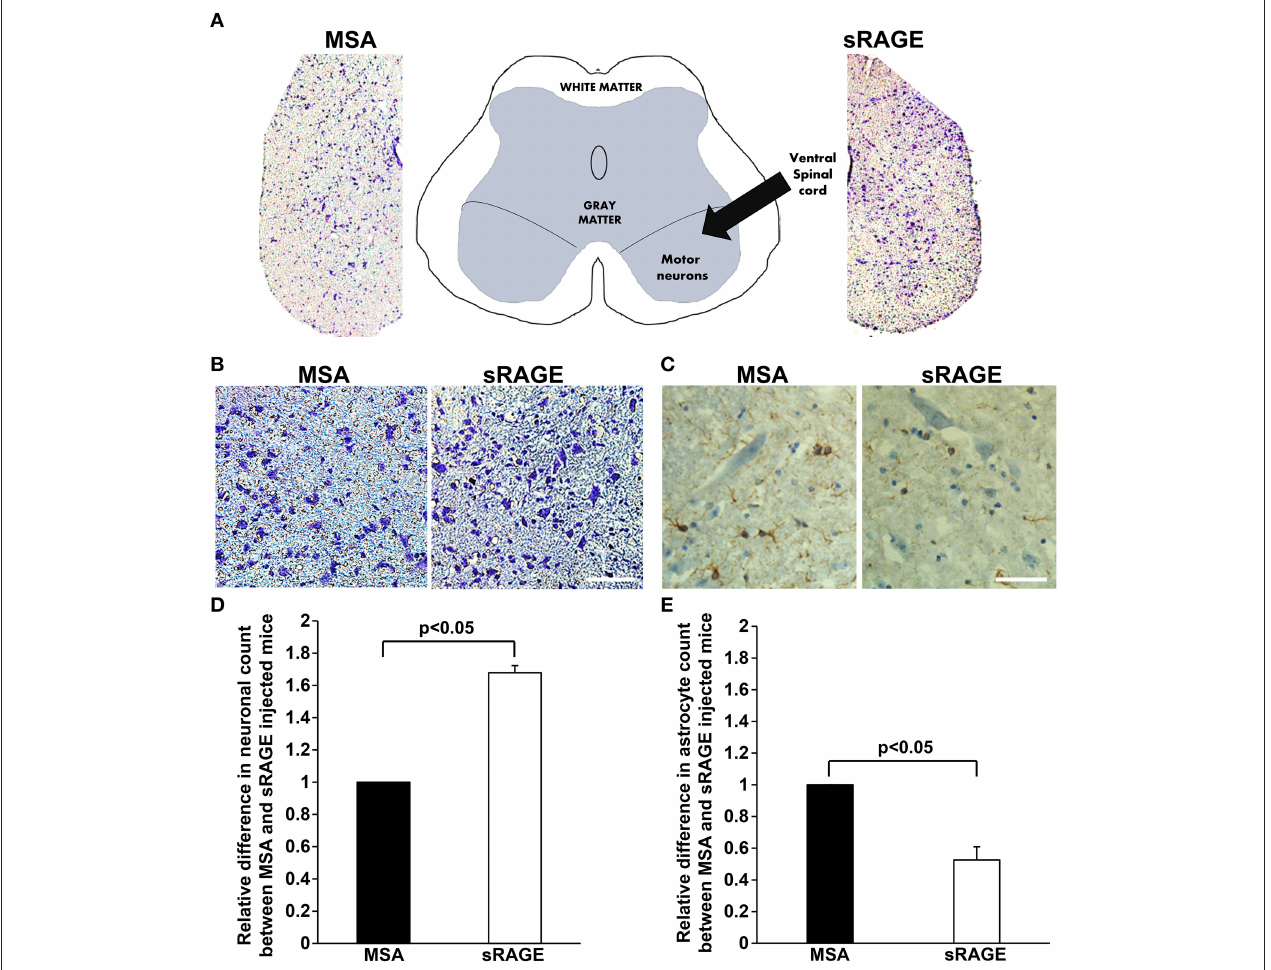
FIGURE 5 | Neuronal count and GFAP expression in terminal-stage SOD1 transgenic mouse spinal cord. (A) A schematic diagram showing different regions of lumbar spinal cord and respective images of cresyl violet stained lumbar spinal cord regions from MSA- and sRAGE-mice as seen under the light microscope. (B) Cresyl violet staining revealing higher number of neurons in spinal cord of sRAGE-treated mice vs. MSA-treated mice at the terminal stage of disease. Scale bar = 75 µ m. (C) GFAP immunostaining showing lower number of astrocytes (brown staining) in sRAGE-treated mice as compared to their MSA-treated counterparts; neurons shown here were stained with Hematoxylin and Eosin. Scale bar = 50 µ m. Results of the quantitative analysis of number of neurons (D) and astrocytes (E) per region of interest in MSA- and sRAGE-treated mice. The results are presented as the relative differences between values for sRAGE and MSA group, n = 5 mice/group. Error bars represent